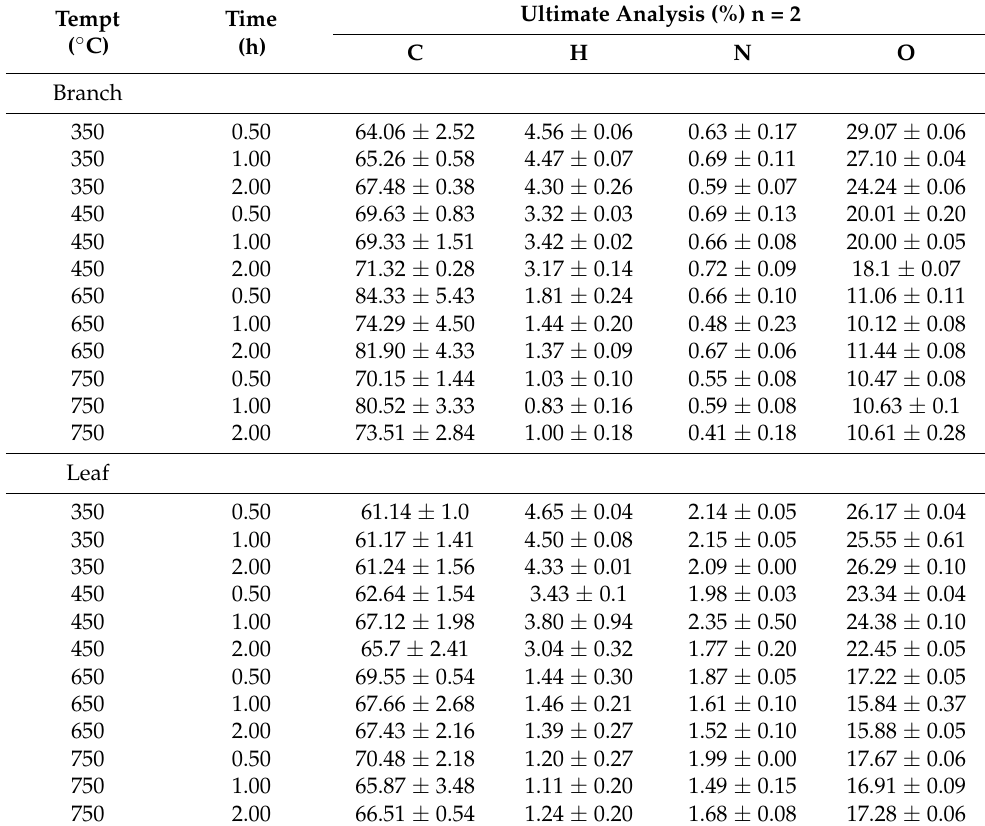
Table 3. Elemental composition for all